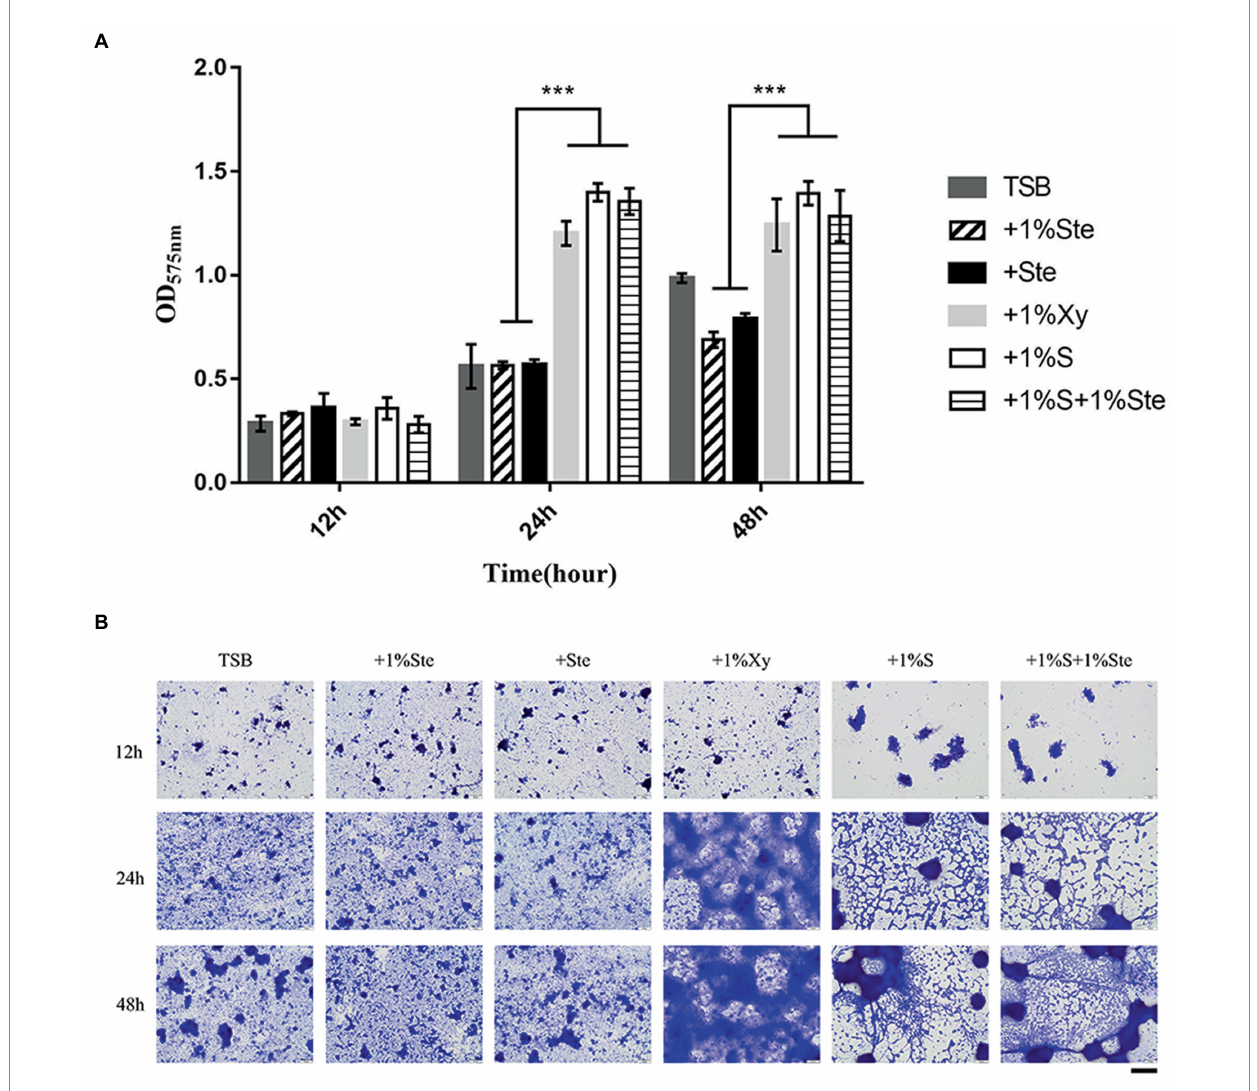
FIGURE 2 Effects of stevioside on the dual-species biofilm formation of S. mutans and C. albicans by crystal violet assay. (A) OD575nm measurement of dual- species biofilm formation at different times. (B) Representative images of dual-species biofilm after crystal violet staining. Results are presented as mean ± standard deviation (SD). Statistical significance is marked by asterisks: ***, p < 0.001. Scale bar: 100 μ